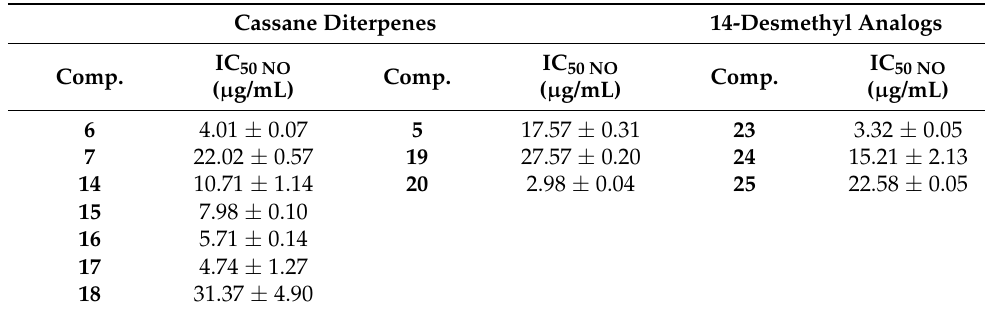
Table 2. The IC 50 NO values of cassanes 5 – 7 , and 14 – 20 and desmethylated analogs 23 – 26 . Cassane Diterpenes 14-Desmethyl Analogs